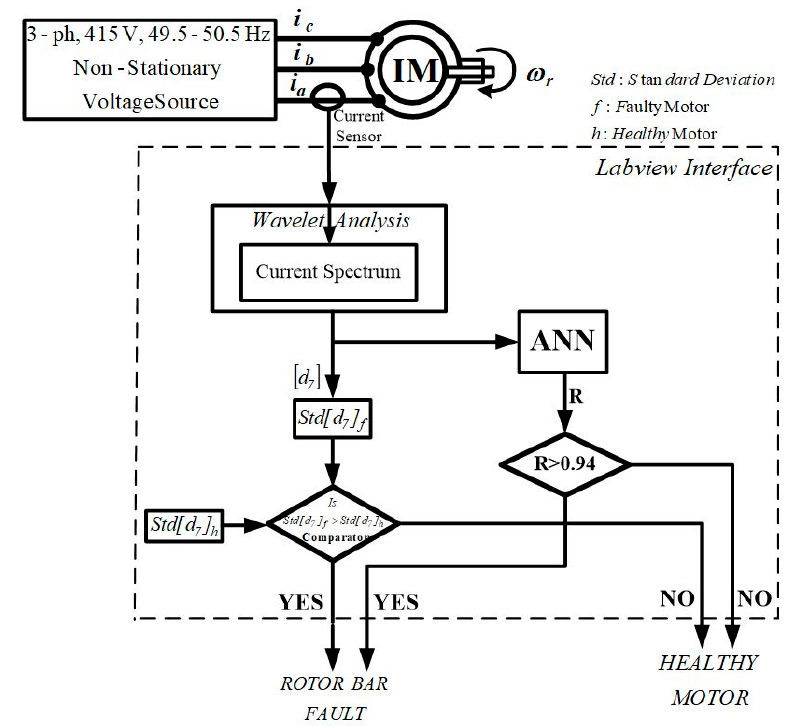
Figure 10. Scheme for DWT- and ANN-based cage fault detection of SCIM. A three-phase, 415 V, 50 ± 1.5% Hz non-stationary source is fed to the SCIM. The scaled-down (1/1000) current of phase-a (i a ) is used for MRA in the simulation study. In addition, ‘dB34’ is used for scrutinising stationary signals in the ‘wavelet analysis’ block. The point-to-point standard deviation of [d 7 ] obtained from the ‘wavelet analysis’ block is compared with the pre-fed values of the standard deviation of [d 7 ] obtained by analys- ing the healthy motor state in the ‘comparator’ block. The standard deviation of [d 7 ] ob- tained from the motor with a faulty cage running in real-time is consistently higher than that of the motor in a healthy state, which indicates the presence of a fault. Furthermore, the instantaneous values of the [d 7 ] detailed coefficient are fed to the ‘ANN’ block, wherein the cascaded forward backdrop-based design has been adopted, and the execu- tion is done using the Levenberg-Marquardt algorithm. The value of the coefficient of correlation (R) obtained from the ANN block is fed to a comparator block which checks whether the value of R value is more than 0.94. A value greater than 0.94 indicates dam- aged rotor bars, whereas a lesser value indicates a healthy rotor bar. This is justified based on the values obtained in Table 2. 4. Real-Time Validation This section details the real-time validation of the proposed cage fault detection scheme in the LabVIEW-based SCIM laboratory prototype. 4.1. LabVIEW-Based Laboratory Prototype The LabVIEW-based laboratory prototype for cage fault detection of 5.5 kW, three- phase, 415 V, 4 pole SCIM (Appendix A) is shown in Figure 11. The motor line current is sensed in the sensing module using LEM current sensors (0–5 A). This line current is fil- tered, discretised, and further digitised using an A/D converter in the data acquisition card (11–30 V (dc), 30 W) for feeding into the LabVIEW interface. The real-time code cor- responding to Figure 10 is generated in LabVIEW. The cage fault detection algorithm is implemented using the acquired data. A sampling frequency of 6.2 kHz and ‘sym34’